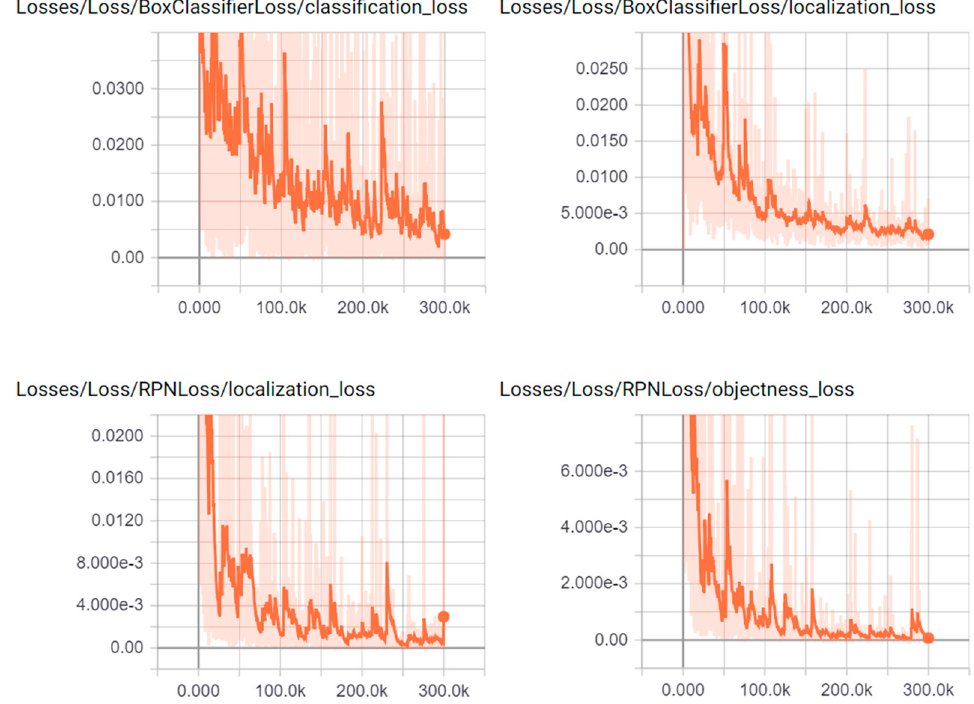
Figure 15. Progress of the training in drone detection using TensorFlow.